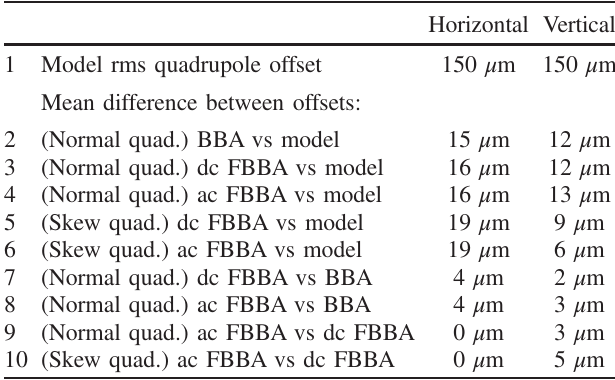
TABLE III. Top line: quadrupole rms offset inserted into the model and to be inferred. The corresponding BPM offsets are retrieved by the simulated measurements and the standard deviation with respect to the expected value (model, lines 2 – 6) or from another technique (BBA or dc FFBA, lines 7 – 10) is computed at all BPMs and averaged over 100 simulated